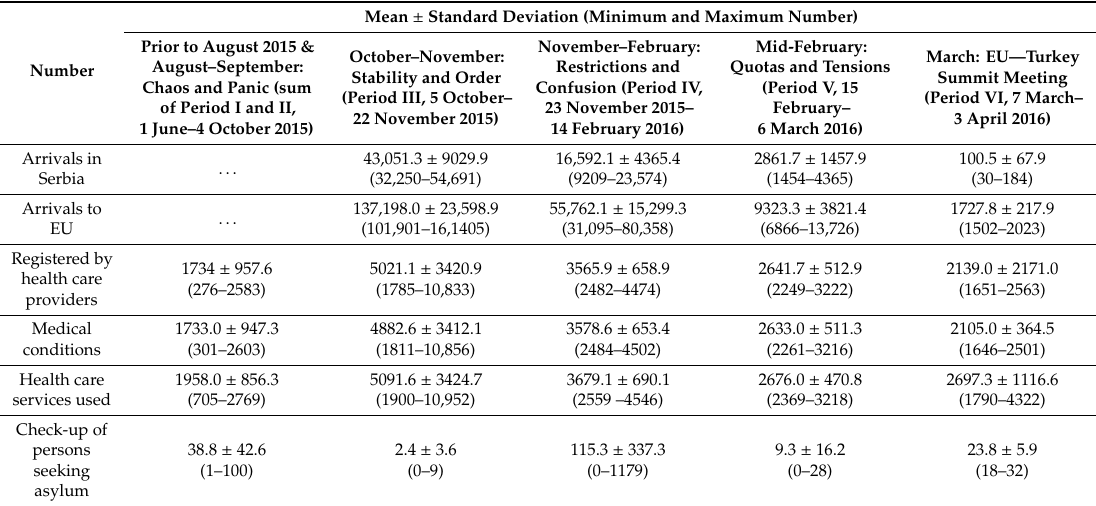
Table 1. Weekly reported number, medical conditions, and health care services used by refugees in Serbia during the Western Balkan Refugee Crises 2015 /